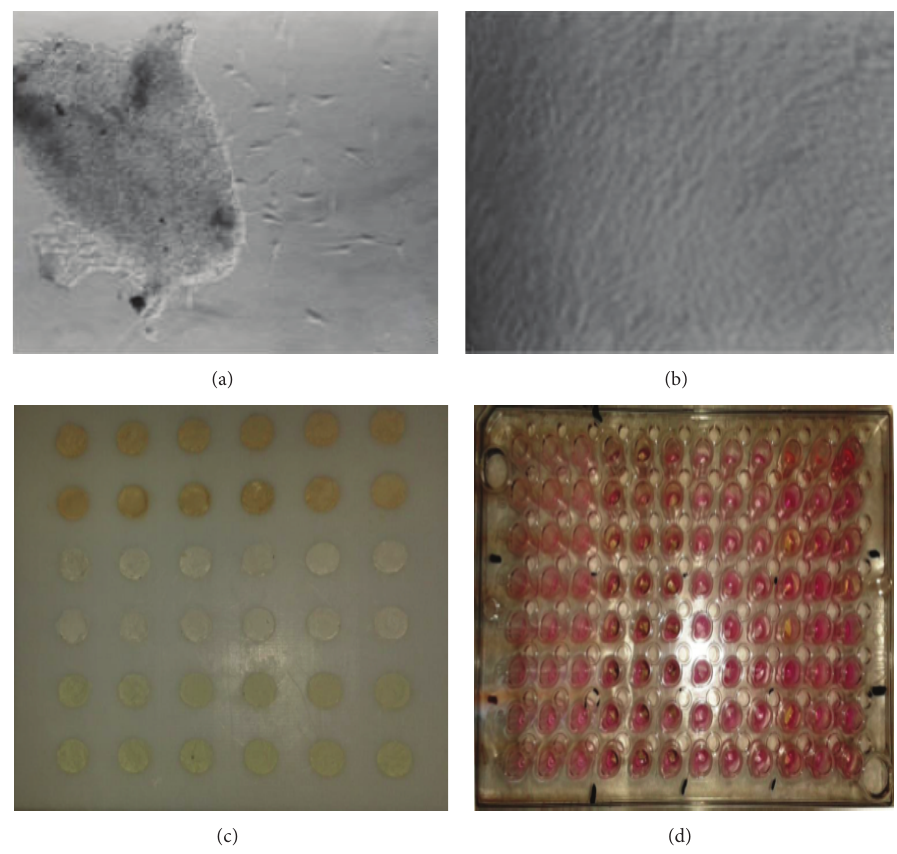
Figure 1: (a) Outgrowth of fibroblast cells from the tissue section ( × 40 magnification). (b) Fibroblast cells reached confluency ( × 40 magnification). (c) Materials inserted into cylindrical polyethylene molds. (d) The culture insert plate with materials placed into the 96-well plate.